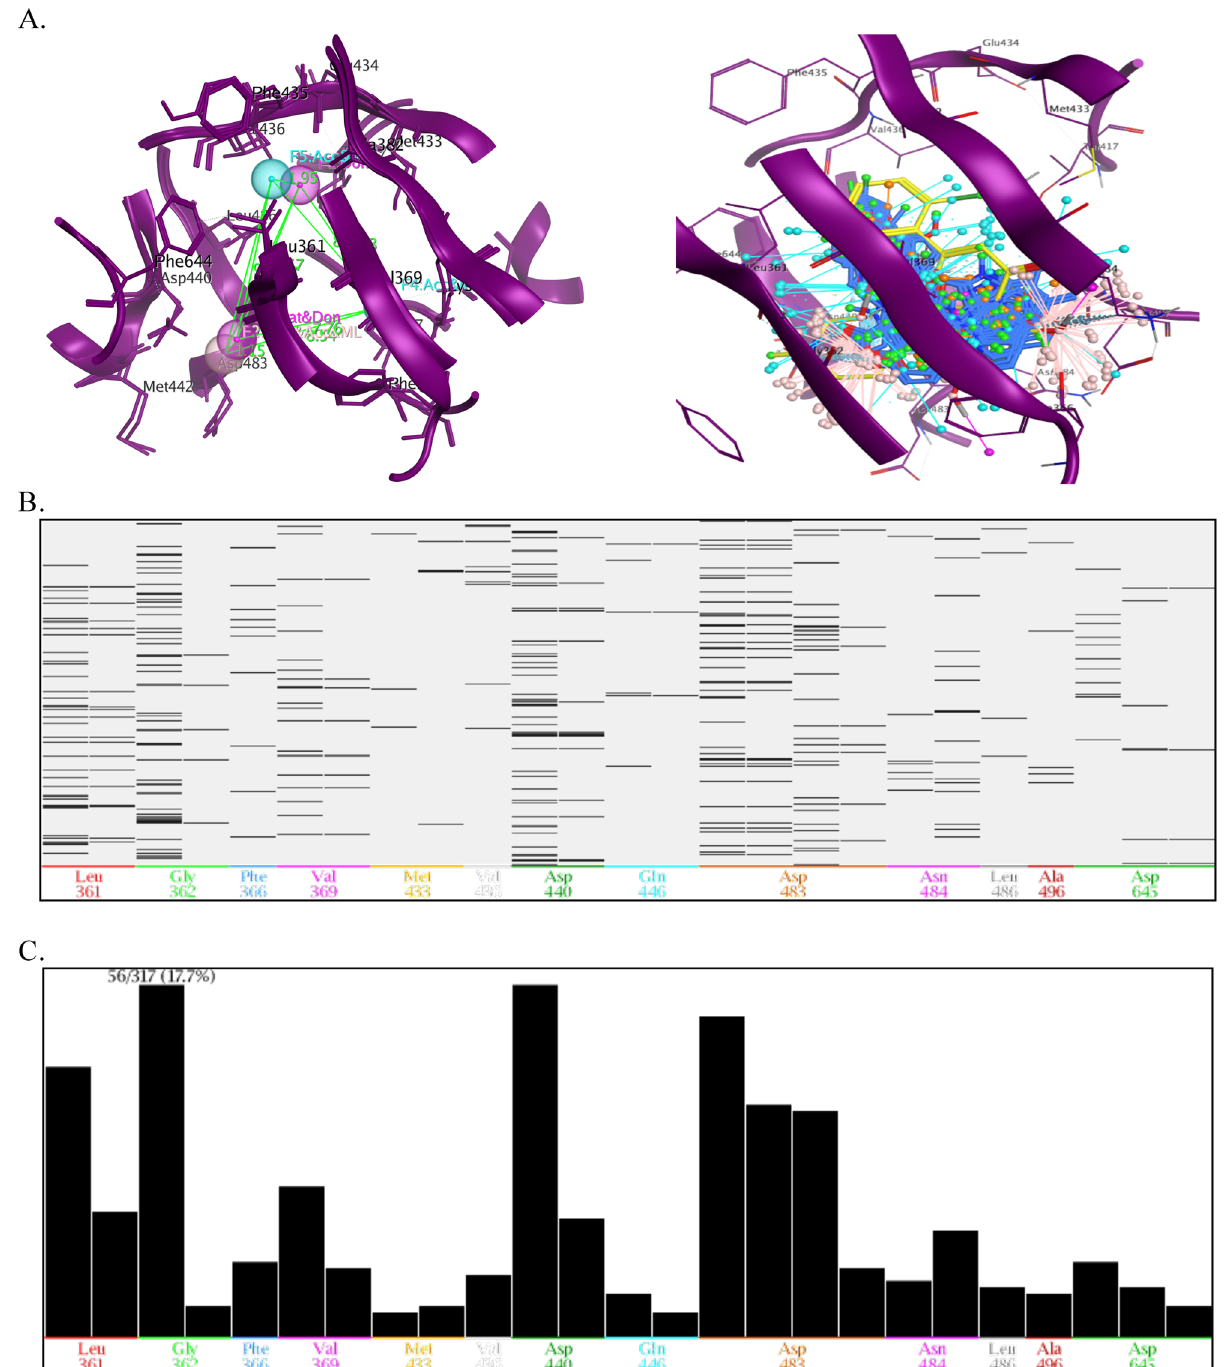
Figure 6. . (A) The distance constraints of vital 3D pharmacophoric features were calculated and displayed in the ATP binding site of PKC-η and Overlays of virtual hits in the ATP binding site of PKC-η including vector projections. The PLIF computed the interactions between the PKC-η PKC-η -virtual, (B) The barcode representation of fingerprint of the PKC-η-ligand complexes: The x-axis displays a three-letter code of the key residues and the y-axis shows the number of PKC-η-ligand complexes, and (C) Population mode refers to the histogram of fingerprint of the virtual hits showing the number of ligands with which each residue